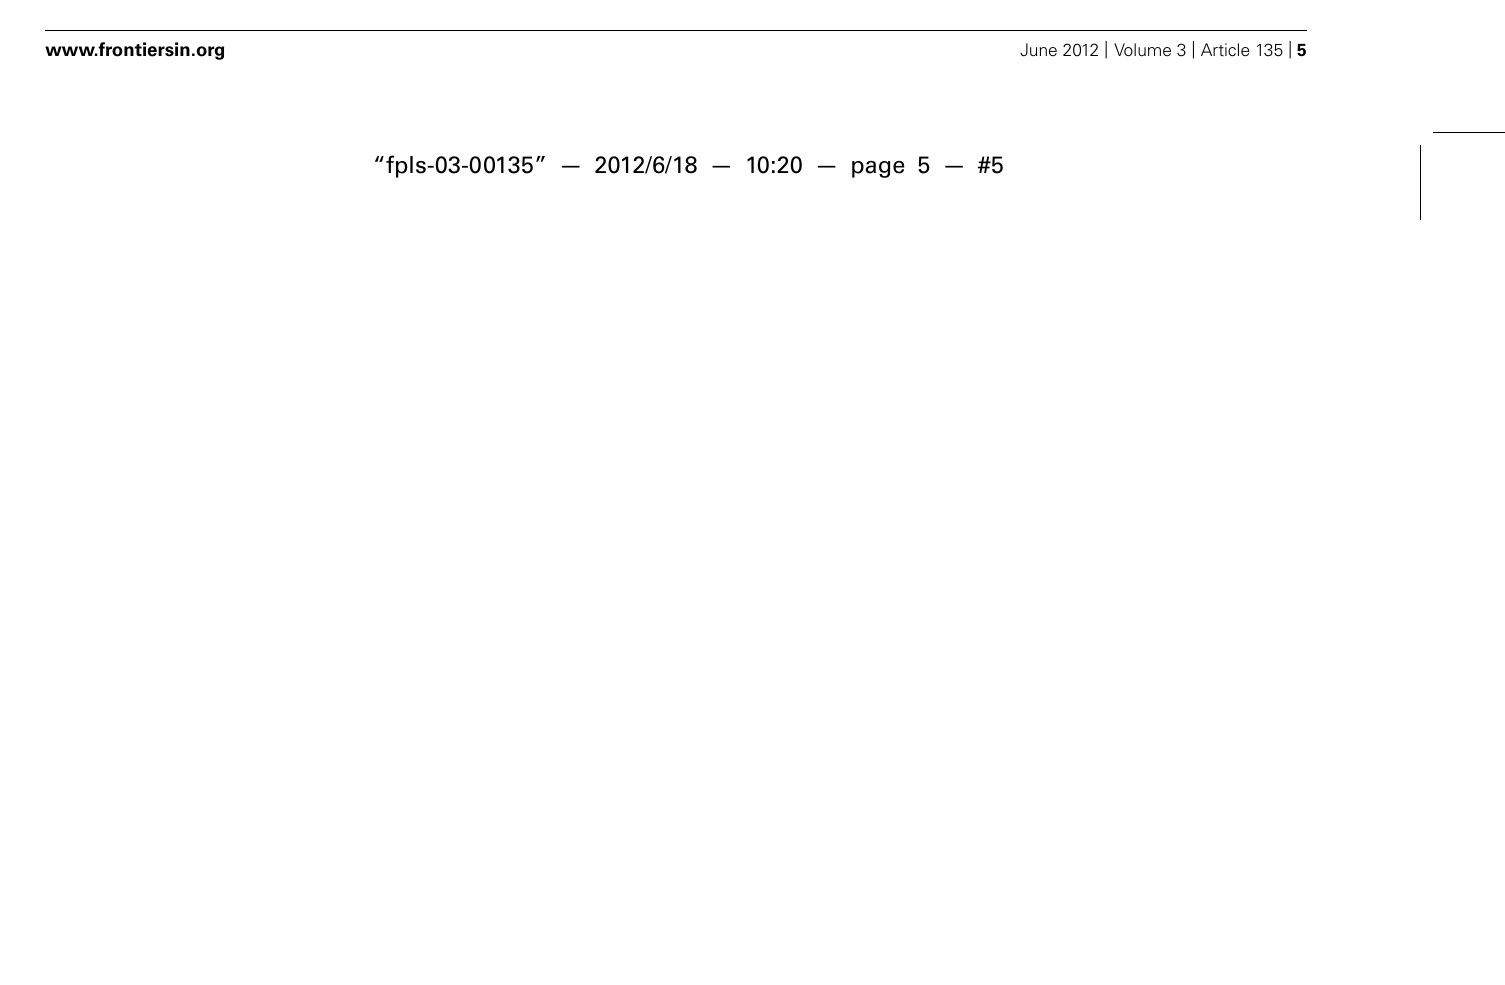
FIGURE 2 | More complex scenarios for retrograde signaling. (A) The signaling molecule generated in and exported from the organelle (filled circles), and the signaling molecule that enters the nucleus (open circles) might not be identical. ABA, which is synthesized in the cytosol from a chloroplast precursor, is a possible example. (B) The signaling molecule